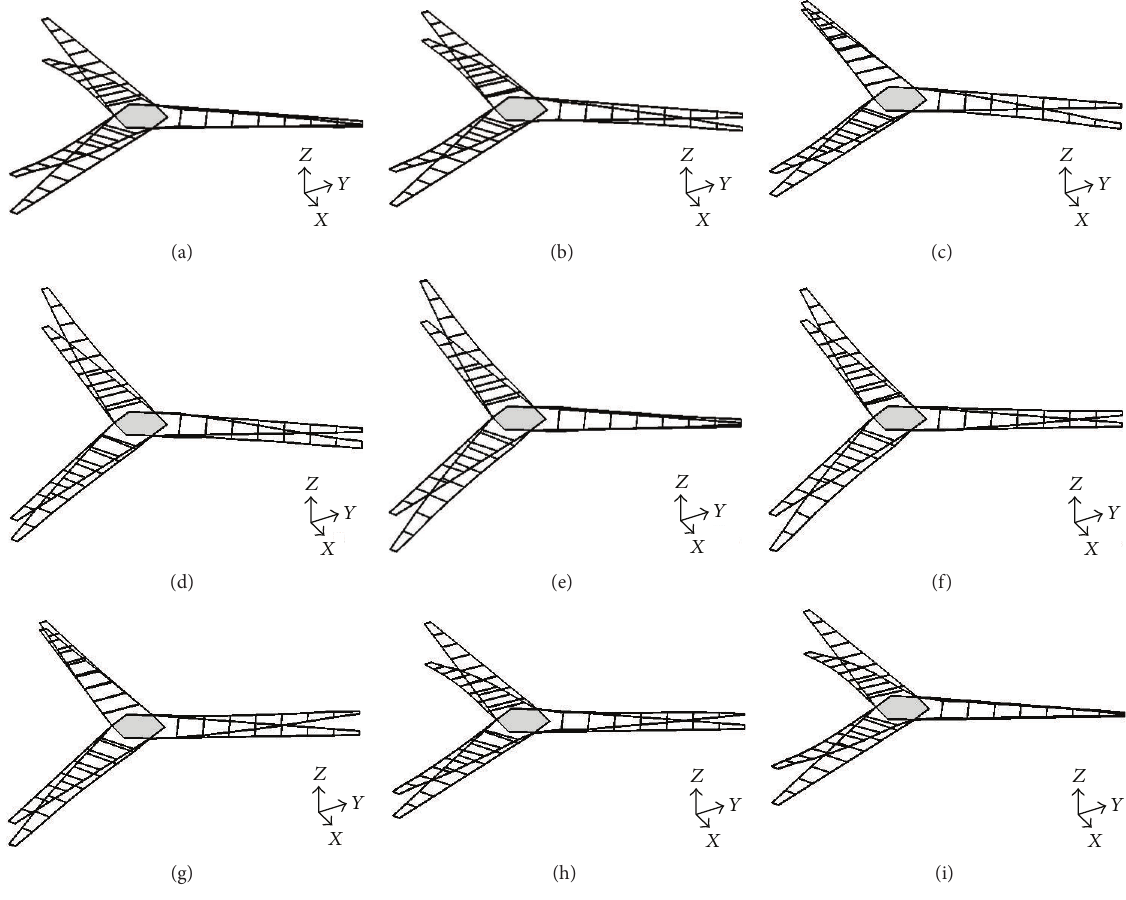
Figure 5: Vibration mode of roundabout